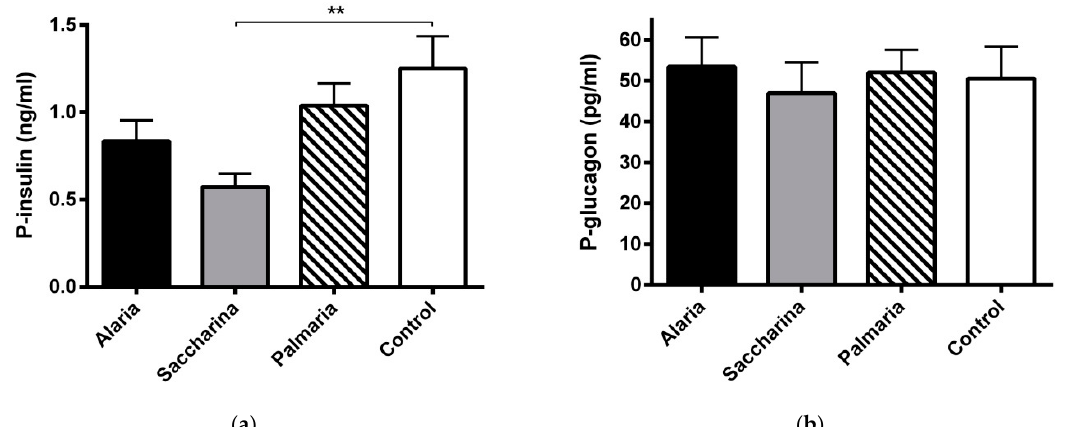
Figure 3. ( a ) Plasma insulin and ( b ) glucagon levels from the KK-Ay mice at the end of the 11-week intervention with diets supplemented with Alaria esculenta , Saccharina latissima , or Palmaria palmata compared to chow (control). The Saccharina group had significantly lower insulin levels compared to control ( p < 0.01). No significant differences were found for plasma glucagon levels between groups. Values are means ± SEM.